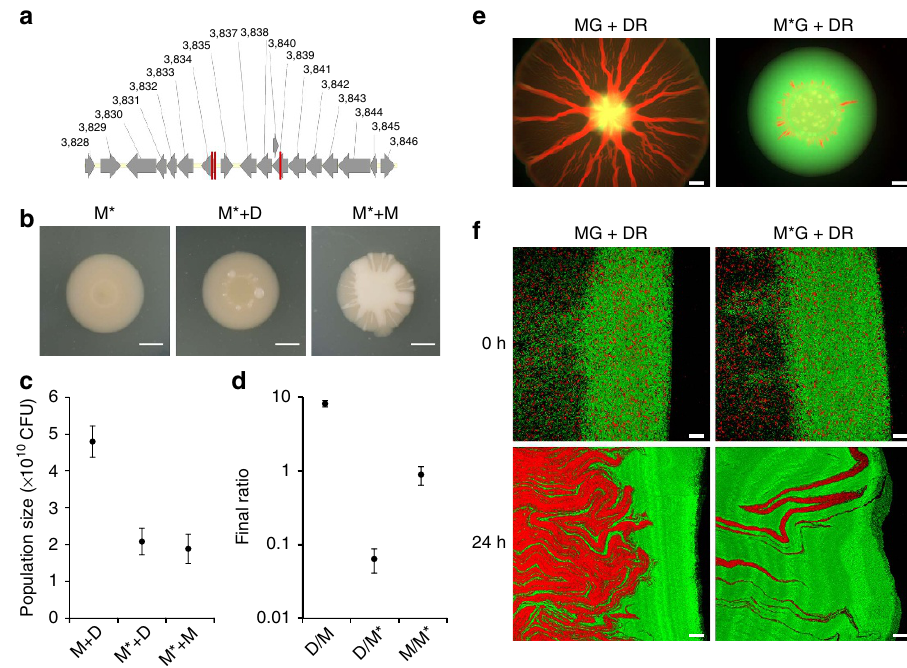
Figure 4 | The mucoid polymer produced by M is required for both spreading and spatial structuring. ( a ) A schematic of the gene cluster associated with mucoid polymer production in M. The numbers represent the annotated Pfl01_ORF designation, and the red vertical bars indicate the sites of transposon insertions that result in the loss of the mucoid phenotype in M. ( b ) Colony morphology of non-mucoid M* (M D Pfl01_3834 ) on its own and in mixture with D or M on day 8. Scale bars, 5mm. ( c ) Estimates of the total population size of various mixed colonies on day 8. One-way analysis of variance (ANOVA; P ¼ 0.000167). Tukey’s honest significant difference (HSD): M þ D versus M* þ D ( P o 0.01); M þ D versus M* þ M ( P o 0.01) and M* þ D versus M* þ M ( P 4 0.05). ( d ) Day 8 strain ratio in mixed colonies as indicated on the x axis. D is streptomycin-resistant and M and M* are kanamycin- resistant. One-way ANOVA ( P o 0.0001). Tukey’s HSD: D/M versus D/M* ( P o 0.01); D/M versus M/M* ( P o 0.01) and D/M* versus M/M* ( P 4 0.05). ( e ) Epifluorescence images of mixed colonies of fluorescently tagged M (green, MG) or M* (green, M*G) and D (red, DR) on day 8. ( f ) Mucoidy in M is needed for characteristic spatial structuring of the two morphotypes. Three-dimensional rendering of confocal images of the edge of mixed colonies after spotting (0h) and 24h later. For all experiments, plotted are the means from three independent colonies, and the error bars represent the s.d. All mixed colonies were initiated at a 1:1 ratio. Scale bars, 2mm or 20 m m in epifluorescence and confocal images,